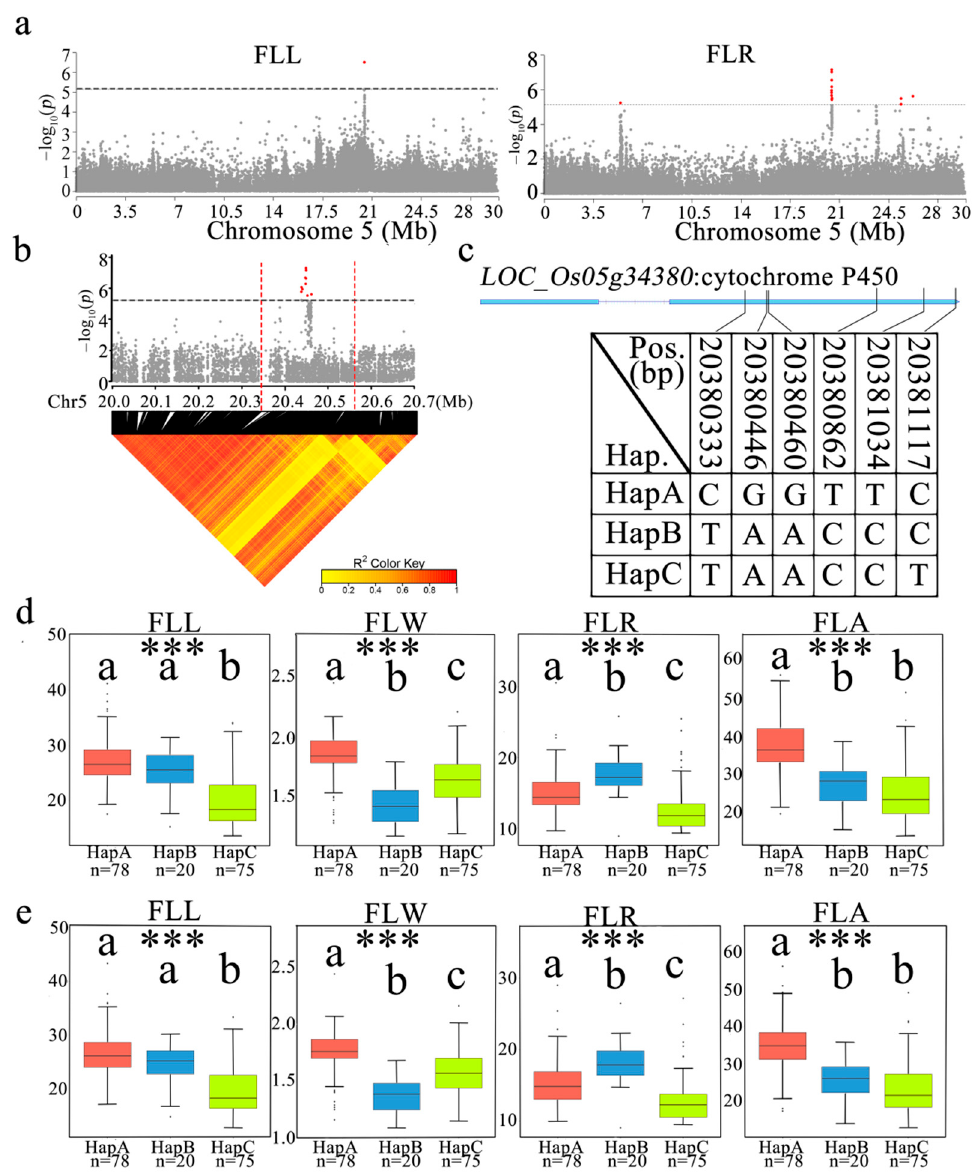
Figure 7. Haplotype analysis of the candidate gene LOC_Os05g34380 : ( a ) Manhattan plots for FLL and FLR. Dashed lines represent significance thresholds; ( b ) Local Manhattan plot (top) and linkage disequilibrium heatmap (bottom), candidate region lies between the red solid lines; ( c ) Schematic representation of LOC_Os05g34380 structure and single-nucleotide polymorphisms in LOC_Os05g34380 cDNA between HapA, HapB, HapC, and HapD. Blue boxes indicate exons; ( d ) Box plots for FLL, FLW, FLR, and FLA in the four haplotypes of LOC_Os05g34380 in all accessions in 2019; ( e ) Box plots for FLL, FLW, FLR, and FLA in the four haplotypes of LOC_Os05g34380 in all accessions in 2020. The number of accessions (n) of each haplotype (Hap) in each panel is given under the x -axis. Boxes show the median and upper/lower quartiles. Whiskers extend to 1.5× the inter-quartile range, with any remaining points indicated with dots. ***, p < 0.001 (ANOVA). Letters indicate significant differences, p < 0.05 (Duncan’s multiple comparison test).